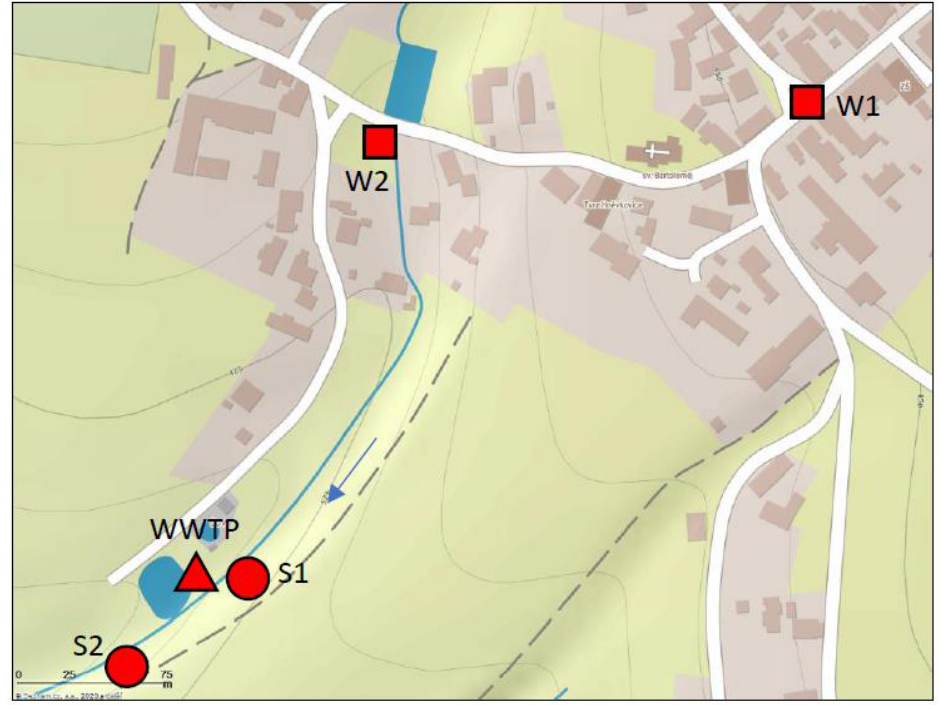
Figure 2. Hnevkovice — sampled wells (W1, W2), effluent from WWTP (wastewater treatment plant) and Hnevkovice stream upstream and downstream from the WWTP (S1, S2).